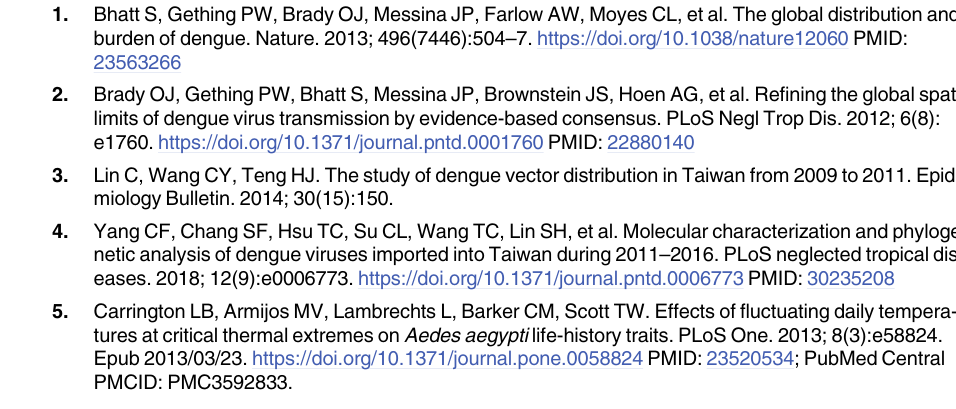
S4 Table. The distribution of combined vgsc genotypes in live and dead female after cyper- methrin exposure bioassay. Genotype was described as the composition of two haplotypes and underlined letter represents the mutant alleles in each position. Tainan city, Kaohsiung city and Lab strain are abbreviated to TN, KH and LS. S5 Table. vgsc genotypes of live and dead mosquitoes after cypermethrin exposure. Boxes with white, gray and yellow represent wild type, heterozygous mutation and homozygous mutation, respectively. The 3 codons listed in the box present the nucleotide sequences of the amino acid in the site of 989, 1016, 1534, and 1763 detected by Sanger